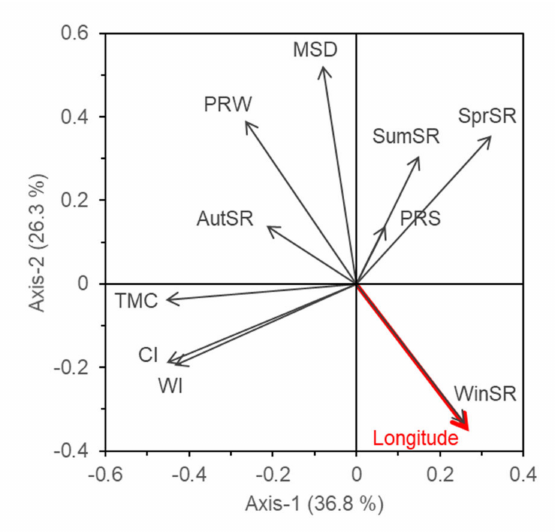
Figure 6. Principal component analysis using longitude and selected environmental factors for 25 populations of A. sachalinensis